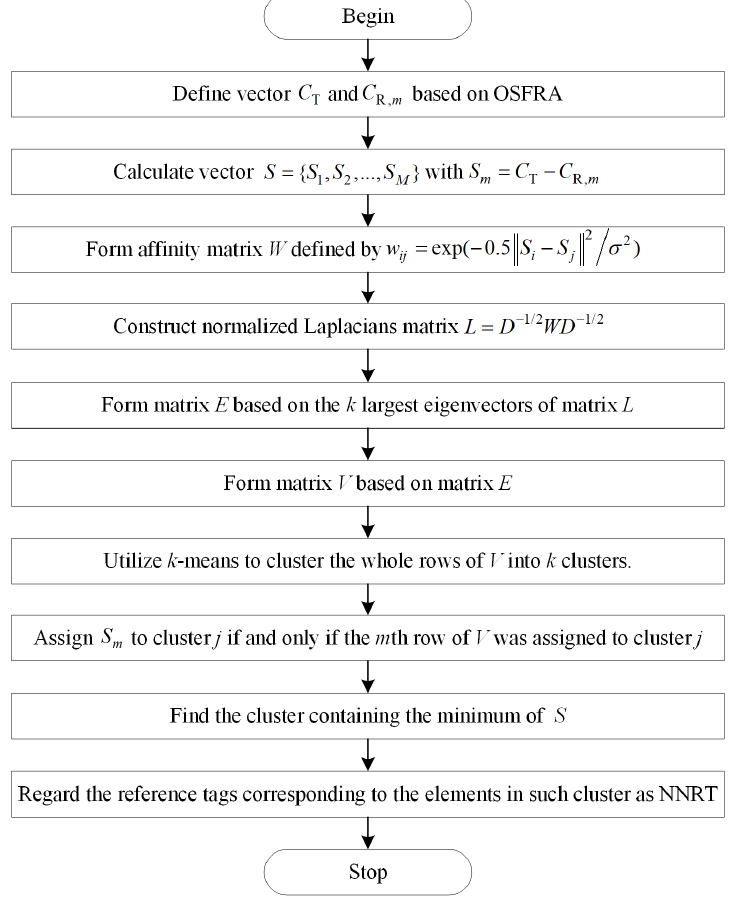
Figure 5. Flow chart of the NJW-based algorithm.